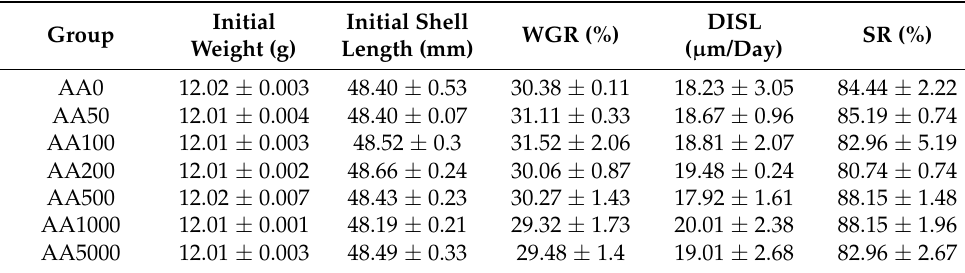
Table 2. Effects of dietary ascorbic acid on survival and growth performance of abalone ( Haliotis discus hannai ) after a 100-day feeding